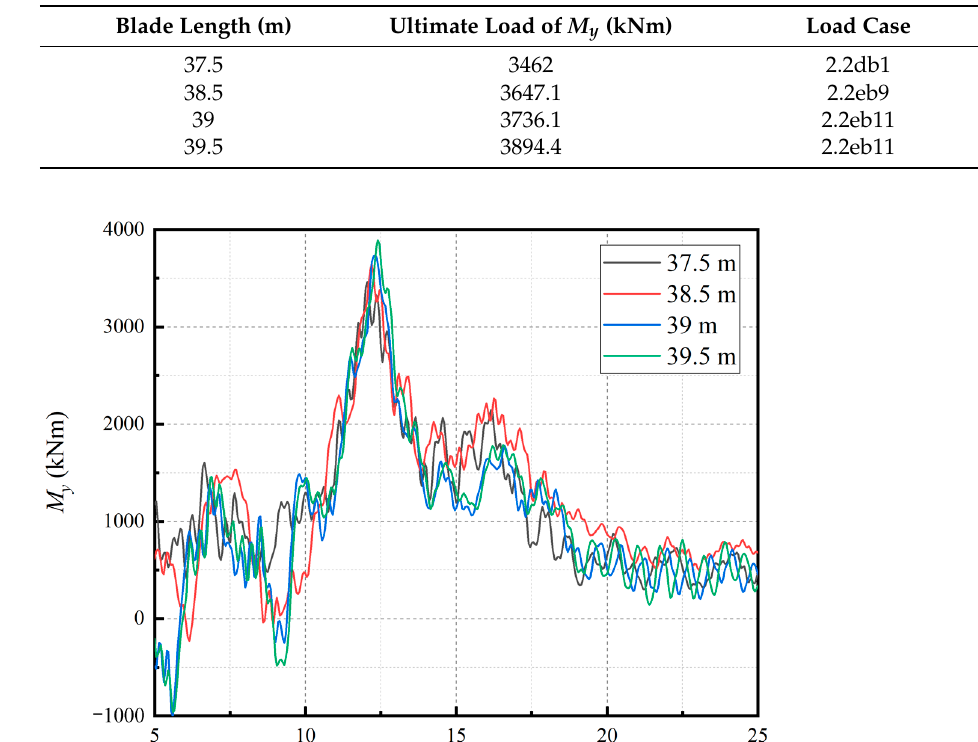
Table 8. Ultimate load M y at blade root. (The label of the load case: the first letter refers to wind speed, “d” for 20 m/s and “e” for 25 m/s; the second letter refers to the type of fault and “b” for pitch runaway (blade 1 pitcher towards fine at − 8 deg/s); the last number refers to the random seed number).